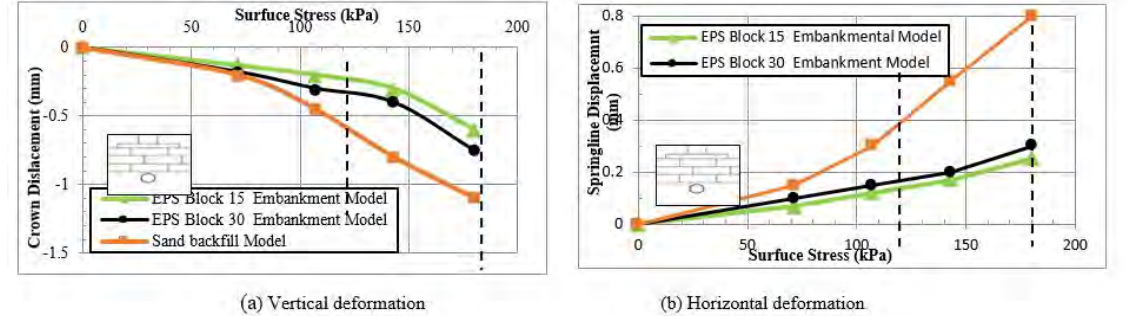
Figure 6. Deformation of UPVC buried pipe under loading in case of EPS blocks (Embankment) model